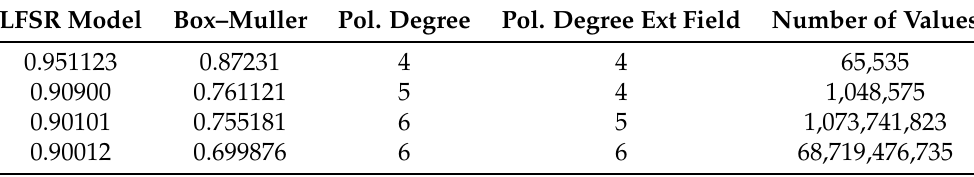
Table 7. Evolution of the p -test values obtained, after applying the Chi Square goodness of fit test method to a set of values, for Box–Muller and for our LFSR